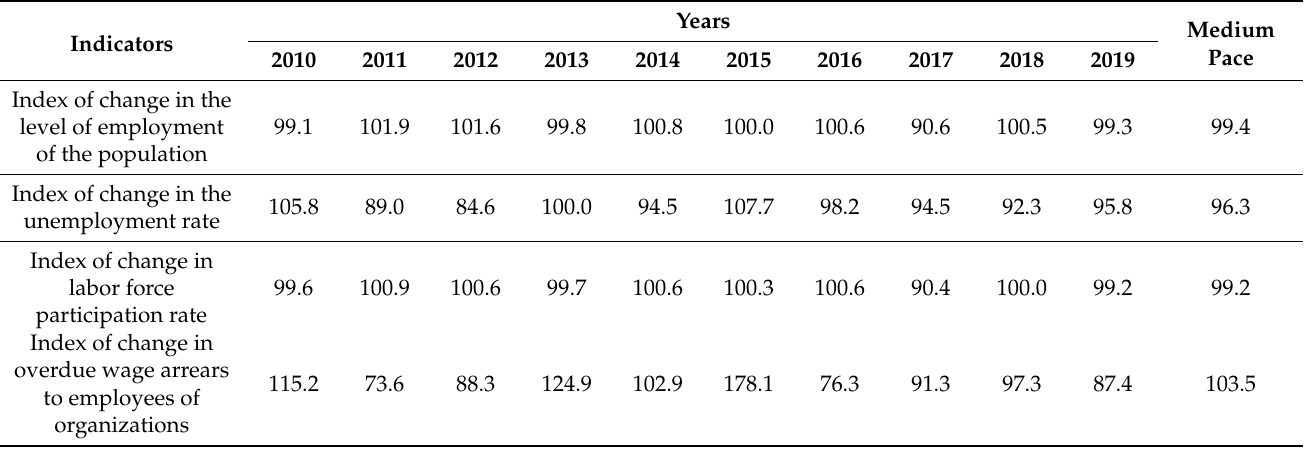
Table 4. Dynamics of changes in indicators characterizing the macro-regional block “Labor” in the